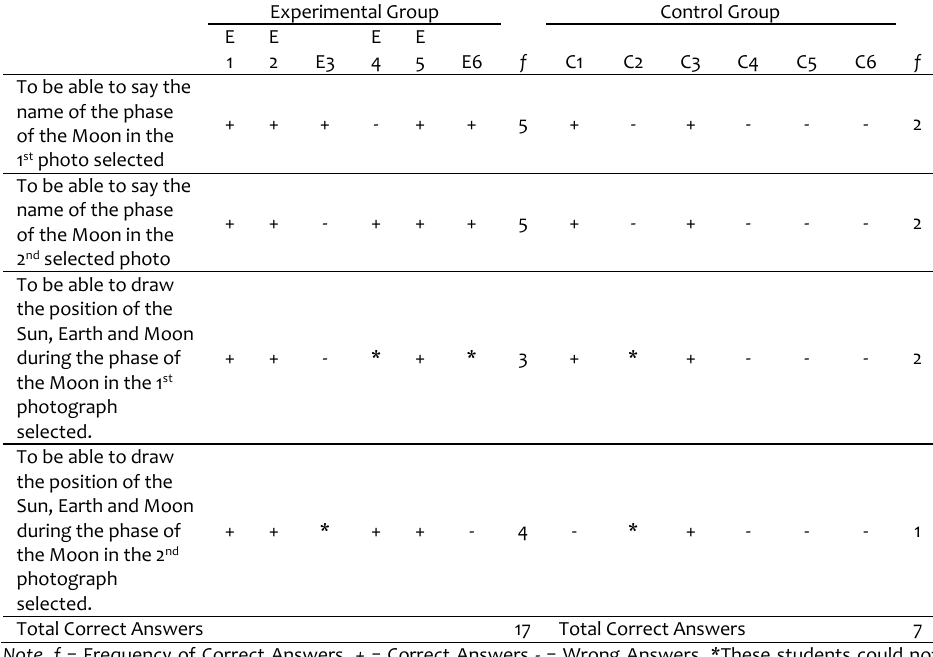
Table 6. The skills of the students to determine the position of the Sun, Earth and Moon while experiencing the phase of the Moon whose photograph is